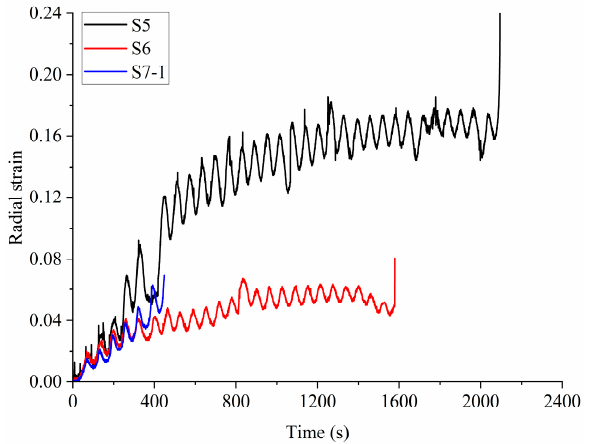
Figure 9. The relationship between radial strain and injection time of samples.